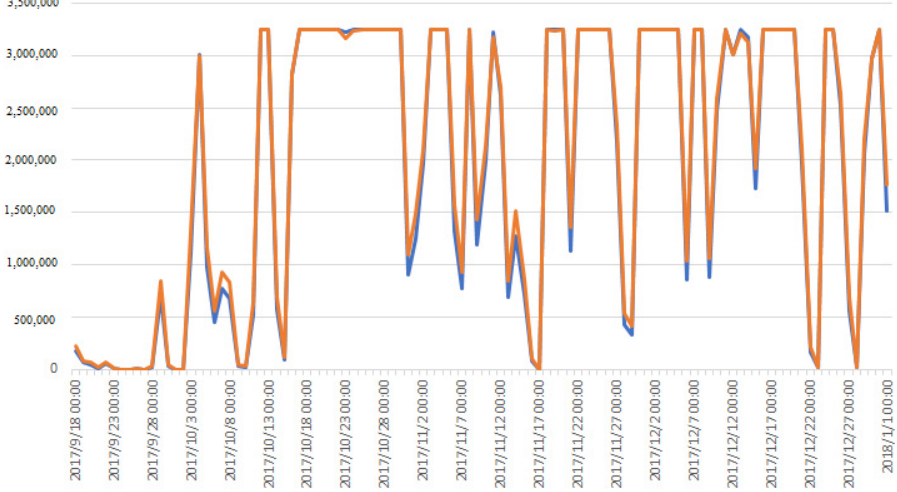
Figure 17. Power chart between 18 September and 1 Januaryin 2018. The orange line is the best power by DGA, and the blue line is the default power.